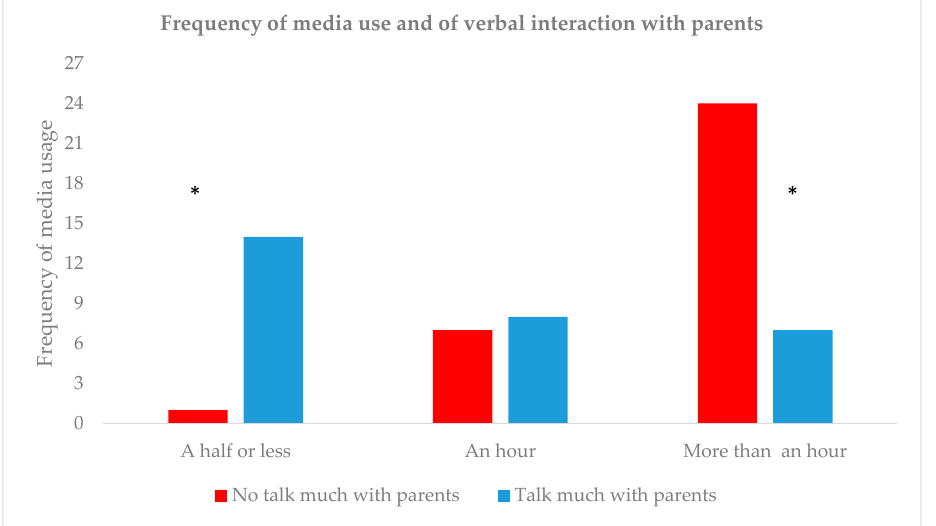
Figure 5. Frequency of media use in hours in relation to the amount of interaction with parents. * p < Figure 0.0001.